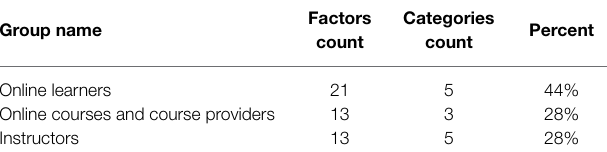
TABLE 1 | Summary of identified factors group wise.